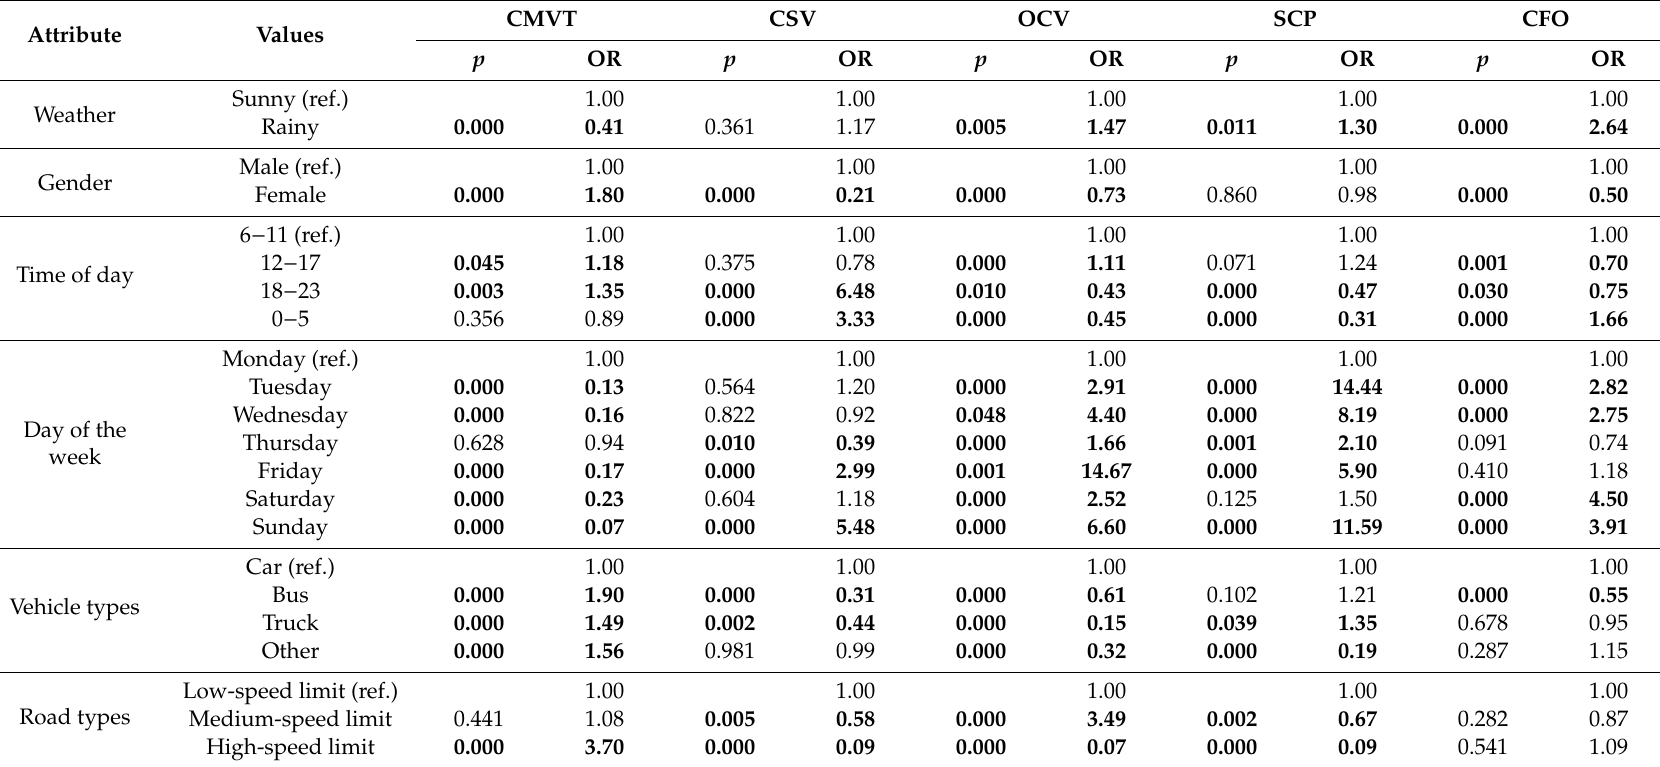
Table 4. Odds ratio results for middle-aged drivers.